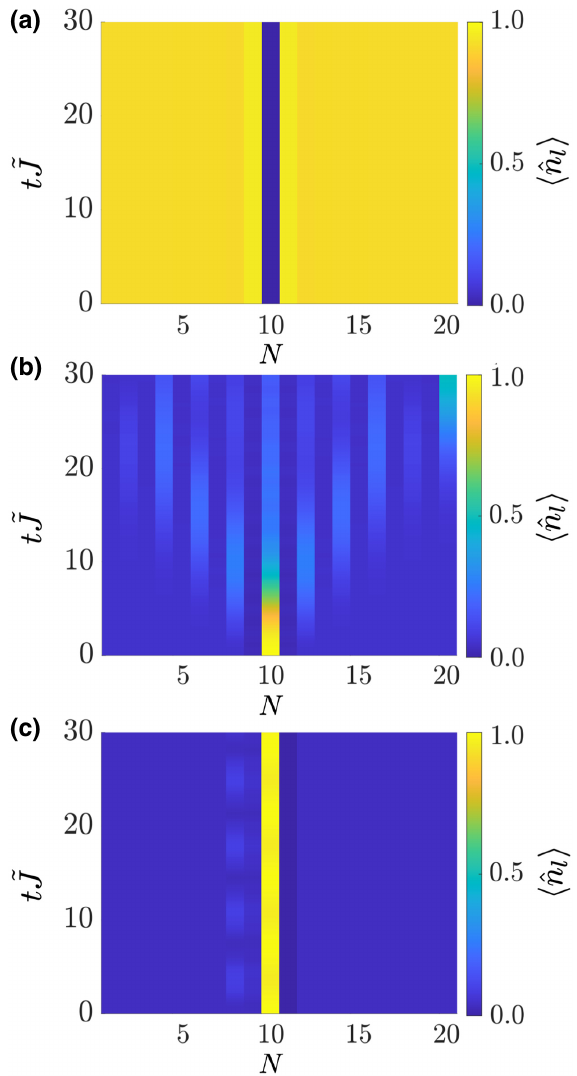
FIG. 5. The time evolution of the physical charge distribution after adding or removing a physical charge. The horizontal axis consists of the spatial lattice sites and the vertical direction is the time (in units of 1 / ˜ J ): (a) m = − ˜ J , h = 0, θ = π , confinement phase; (b) m = ˜ J , h = 0, θ = π , deconfinement phase; (c) m = ˜ J , gh = 0.25 ˜ J , and θ (cid:12)= π